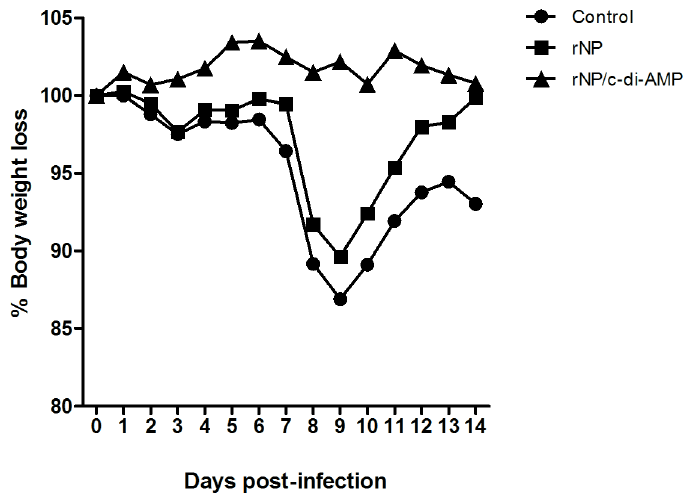
Figure 5. Protection of vaccinated mice against challenge with the influenza A virus. BALB/c mice (n=6) were immunized on day 0 and 21 with rNP (10 m g/dose) alone or co-administered with c-di-AMP (10 m g/dose) by intranasal route, whereas control animals received PBS. All groups were challenged on day 60 with a non-lethal dose of the influenza strain A/Puerto Rico/8/34 (H1N1). Animal body weight was then monitored for 14 days. Results are expressed as average percentage of weight loss.